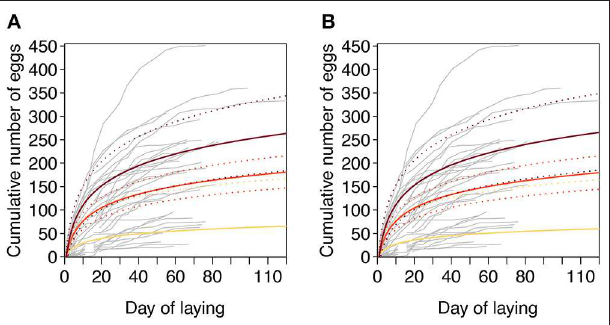
FIGURE 3 | Model predictions of the cumulative number of eggs for minimum (yellow line), mean (red line), or maximum (dark red line) hue values. Gray lines represent the raw data from 39 females. Each curve represents the cumulative number of eggs laid up to each day by each individual female. Fitted values (solid lines), predicted from an LMM, with 95% credible intervals (dashed lines) are given assuming average values for (A) weight and (B) SVL as independent variables in the model. N =